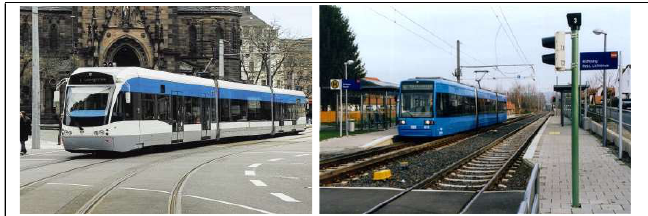
Figure 3. Lakošin system in European cities (Saarbrucken,